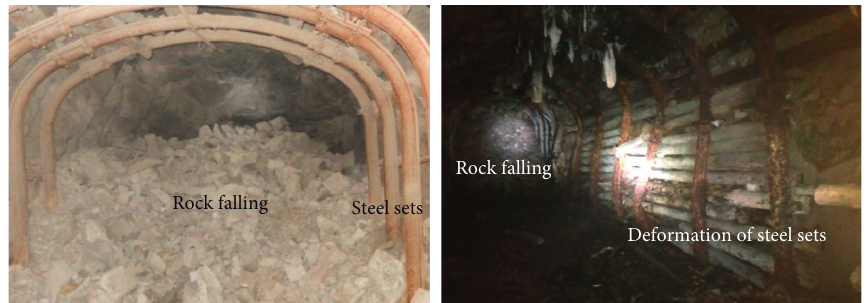
Figure 3: The rock falling and deformation of steel sets in the weak rock